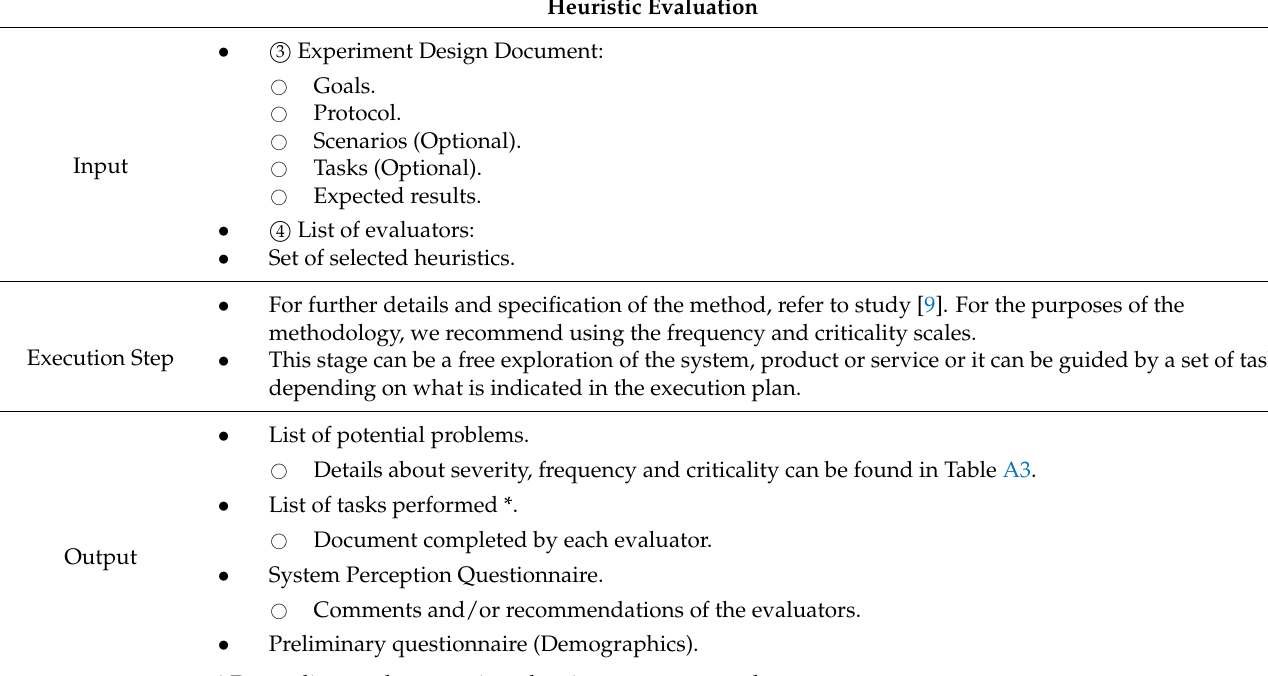
Table A11. Heuristic Evaluation Specification. Heuristic